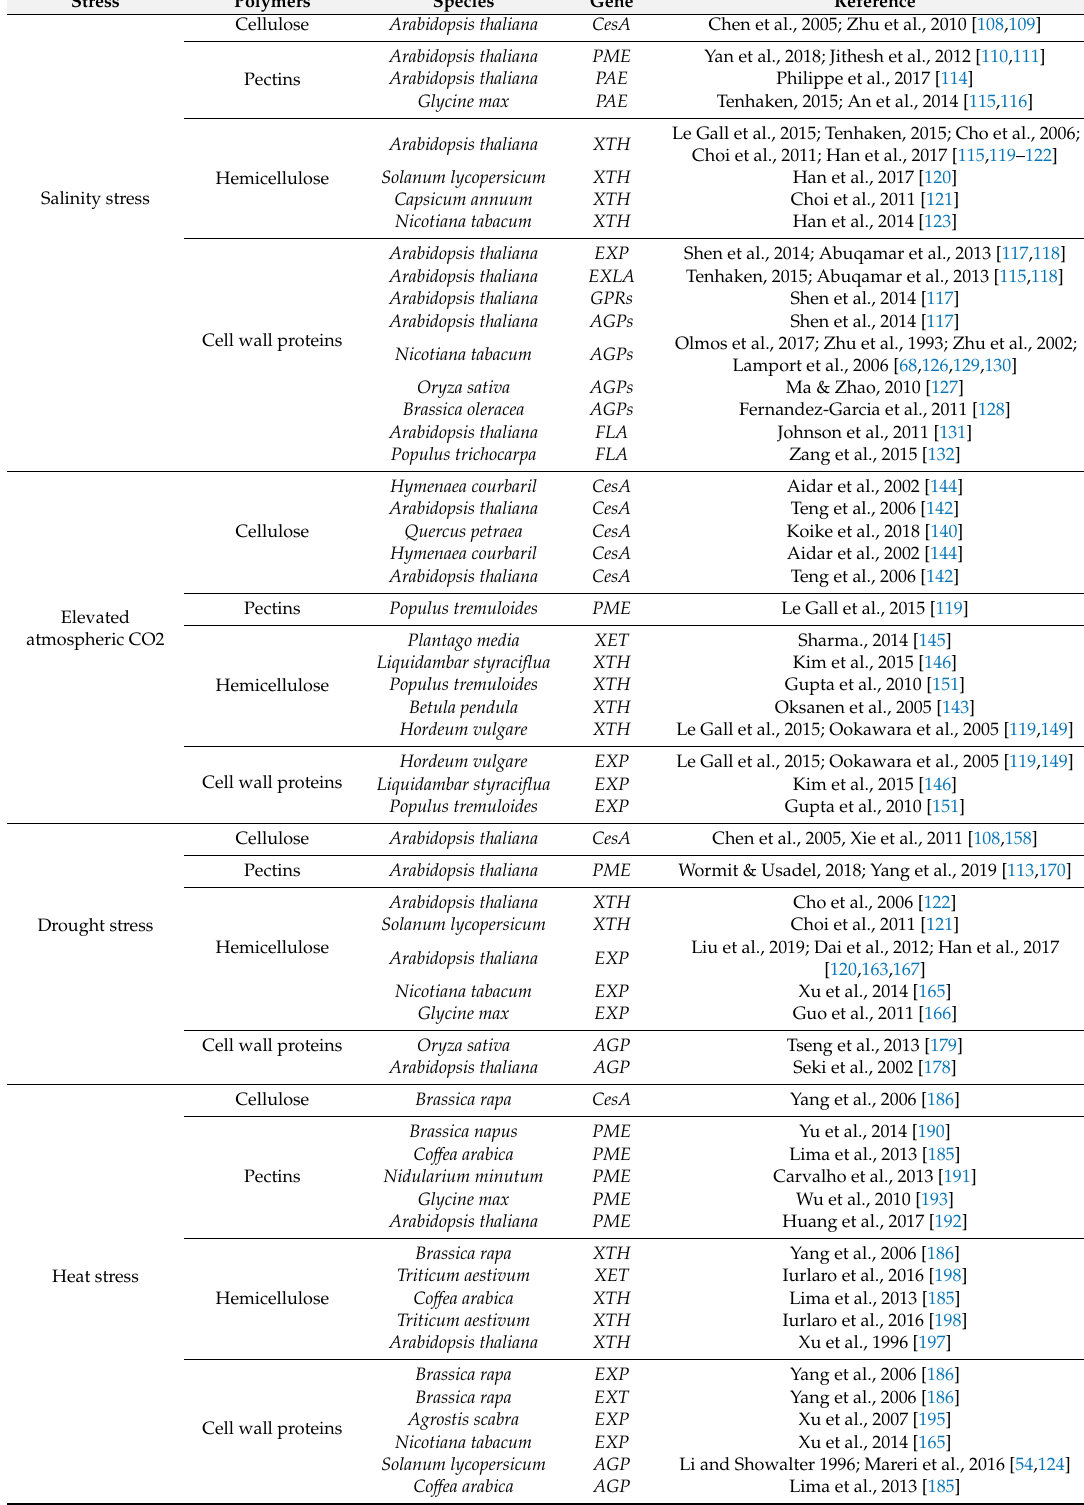
Table 1. Cell wall modifications discussed in this work that were reported in response to salinity, drought, heat, and elevated CO 2